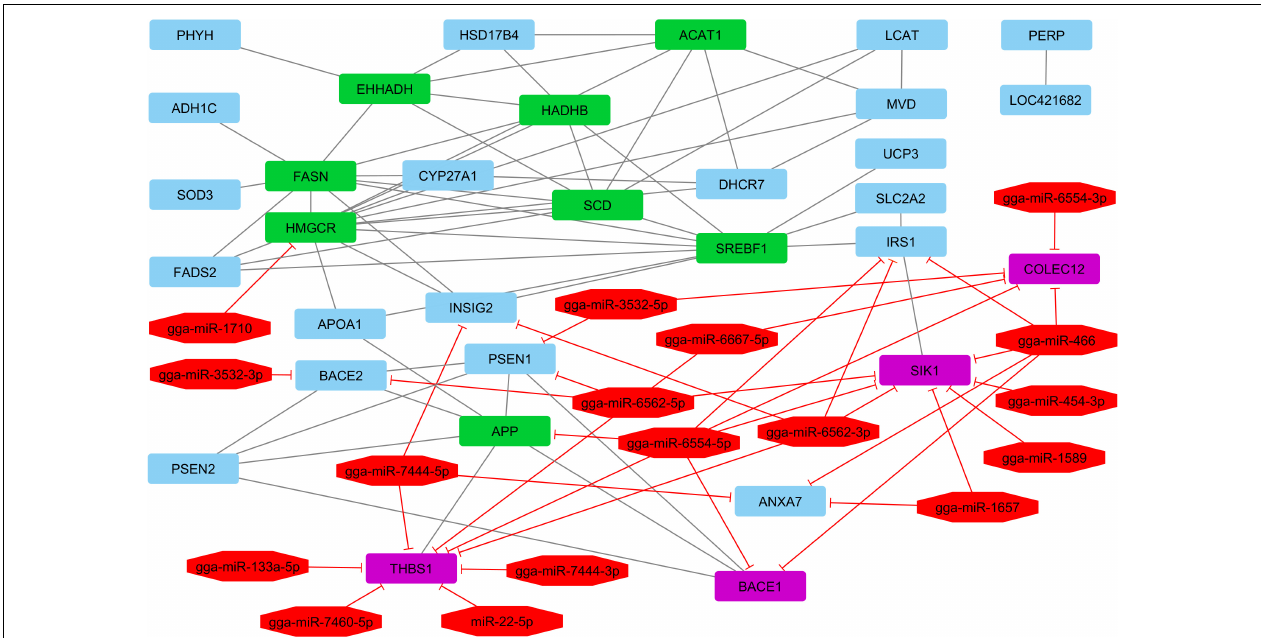
FIGURE 3 | Interactive bipartite network (gene–miRNA) affecting the abdominal fat storage and metabolism in the poultry. In this network, the quadrilateral points represent genes, and the octagonal points represent miRNAs. About miRNAs and target genes, the edges indicate the suppressing role of miRNAs. The edges also represent the gene–gene interactions. The green quadrilateral nodes represent the hub genes. Purple quadrilateral nodes are the genes with the highest suppression by miRNAs.